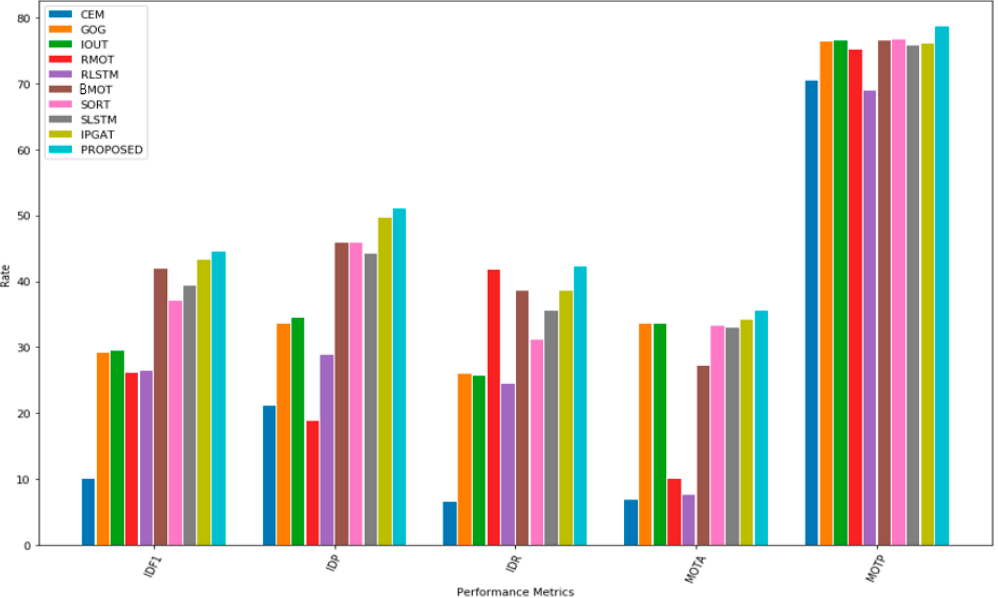
Figure 8. Comparative analysis of proposed method with existing methods. CEM: continuous energy minimization, GOG: global optimal greedy, IOUT: intersection-over-union tracker, RMOT: relative motion online tracking, RLSTM: relative long short term memory, Bayesian multi-object tracking (BMOT), SORT: simple online and real-time tracking, SLSTM: social long short term memory.